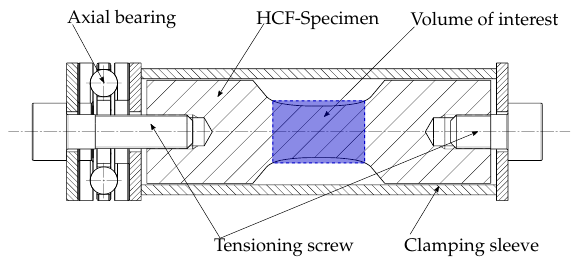
Figure 14. Clamping device for computed tomography analysis.